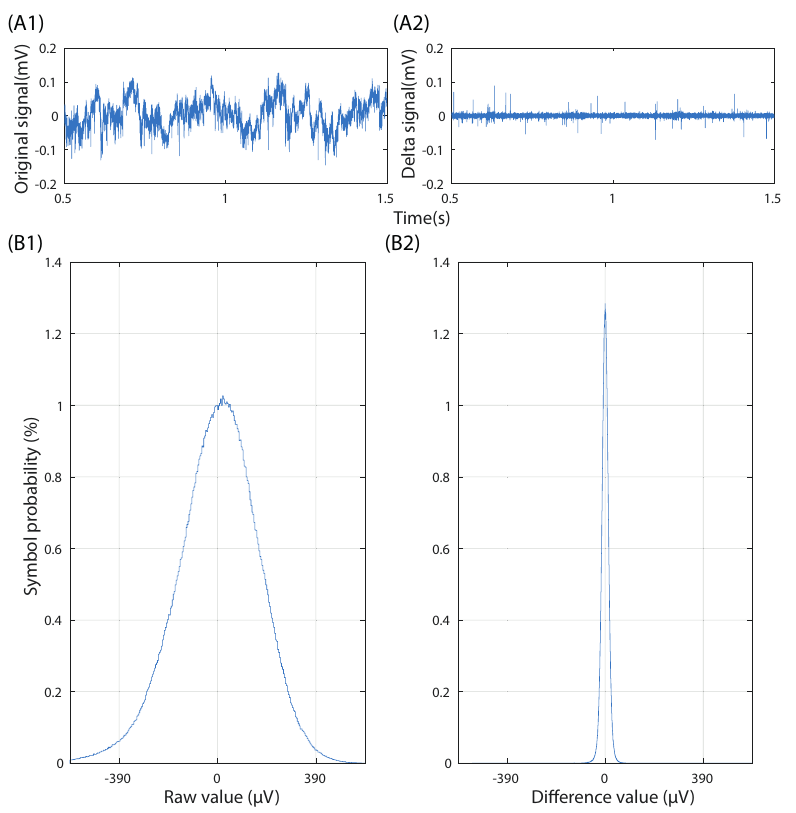
Figure 4. Comparison between a 20 min neural signal in raw form ( A1 , B1 ) and after delta-encoding ( A2 , B2 ). ( A ) 1 second time-domain sample of the raw signal ( A1 ) and the delta-encoded signal ( A2 ). ( B ) Symbol probability of the full recording in raw form ( B1 ) and after delta-encoding ( B2